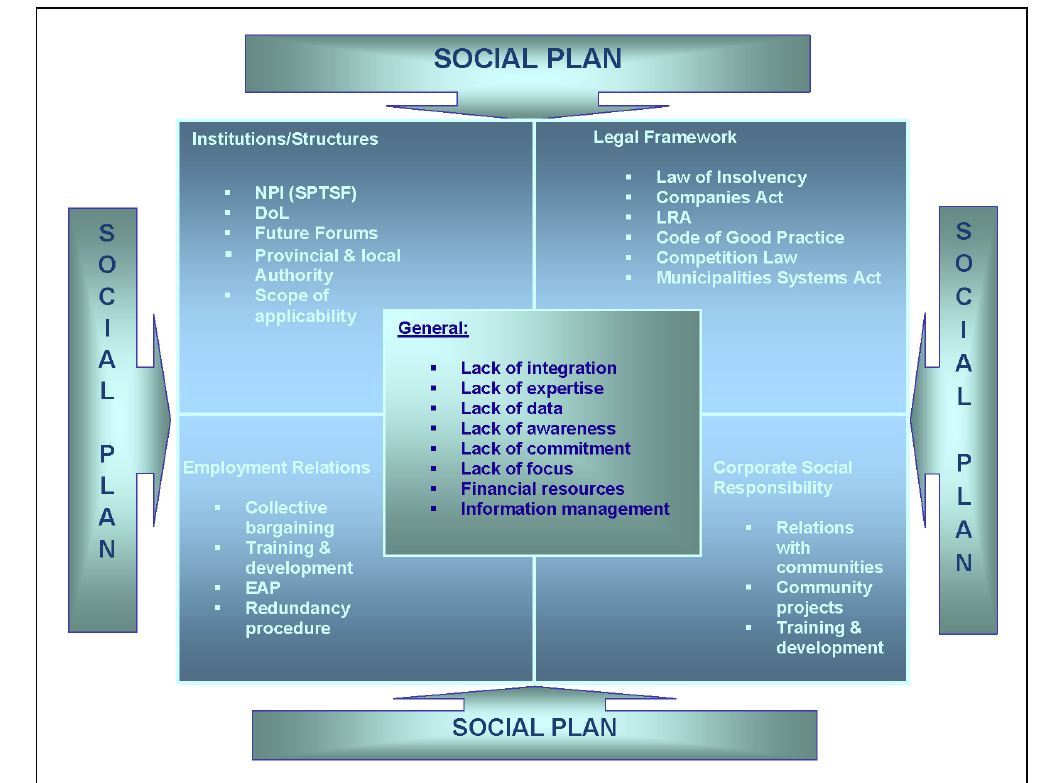
Figure 3 The categorisation of challenges under